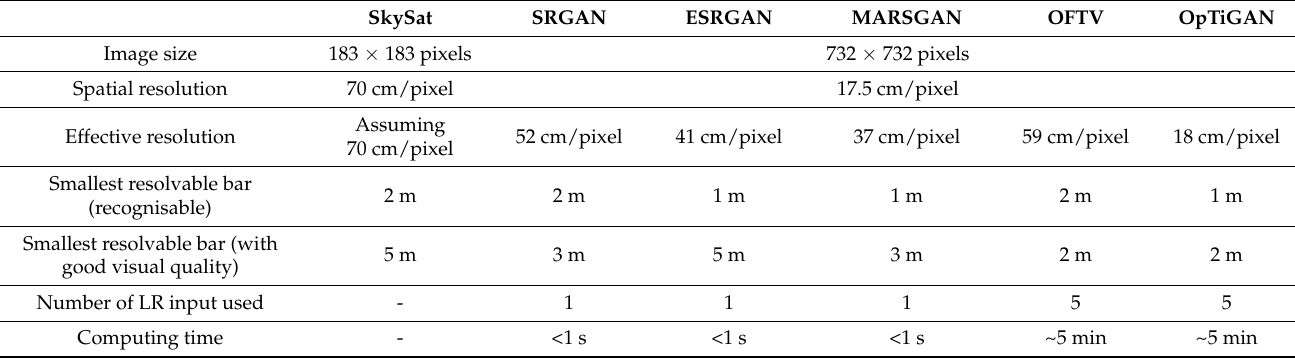
Table 10. Summary of the effective resolution derived from Figure 11 and Table 9, the smallest resolvable bar pattern targets observed from the SkySat image and each of the SRR results, in comparison to Figure 5, as well as the number of input images used and computing time for the Baotou Geocal site.